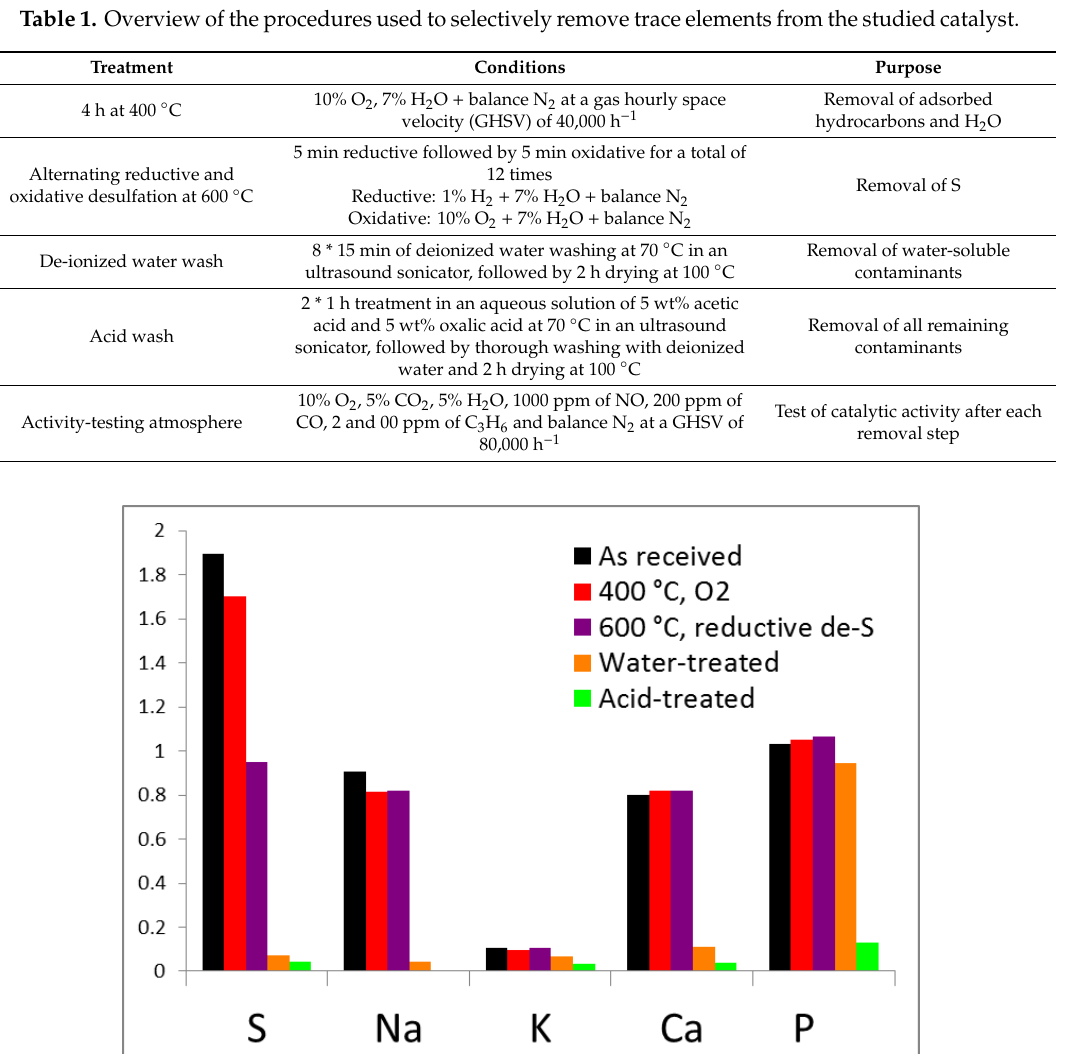
Figure 3. Effect of contaminant removal procedures on contaminant contents, as determined by XRF. The used contaminant removal procedures are described in Table 1.